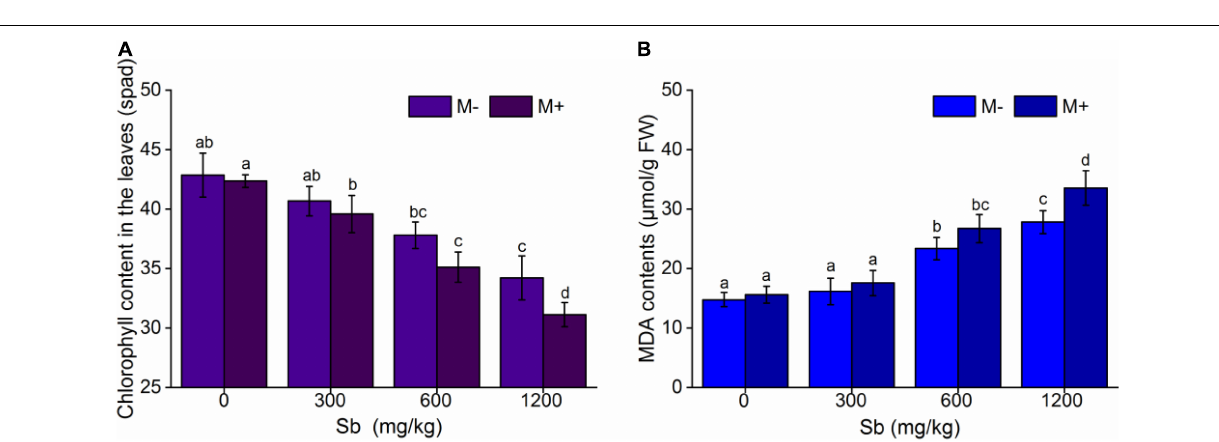
FIGURE 3 | Effects of AMF on chlorophyll contents and MDA contents of rice leaf. (A) Chlorophyll content in the leaves, (B) MDA content in the leaves. FW represents fresh weight. Error bar was calculated from three parallel samples. Error bars sharing no common letter indicate that chlorophyll content and MDA content are significantly different at P < 0.05 level for treatments. The data are means ± SDs ( n =